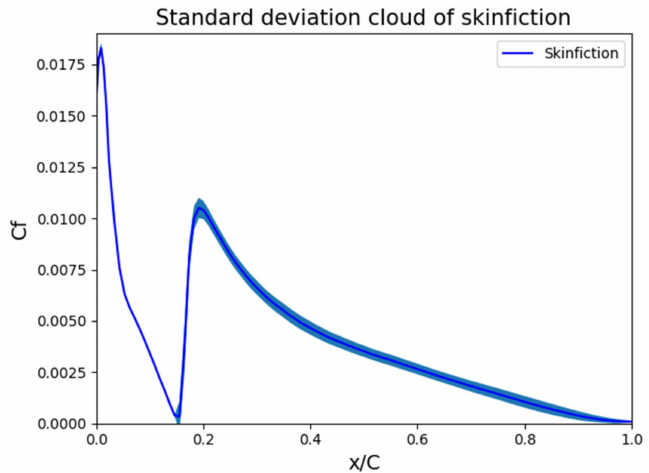
Figure 12. Variation of the skin friction coefficient of the upper surface of the A-airfoil for the point-collocation NIPC